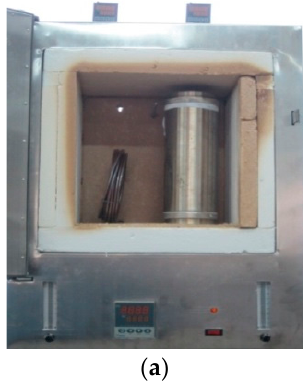
Table 5. Gas concentrations during coal sample heating and oxidation.